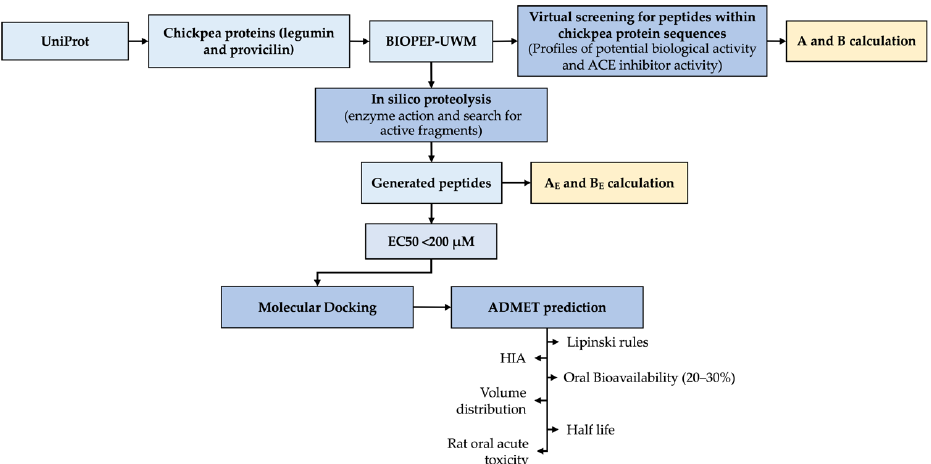
Figure 1. Workflow employed to characterize CP with ACE-I inhibitory capacity. A: frequency of ACE-I-inhibitory fragments, B: potential ACE-I inhibitory activity, A E : frequency of released fragments with ACE-I-inhibitory activity, B E : ACE-I-inhibitory activity of peptides potentially released by enzymatic hydrolysis, HIA: human intestinal absorption.